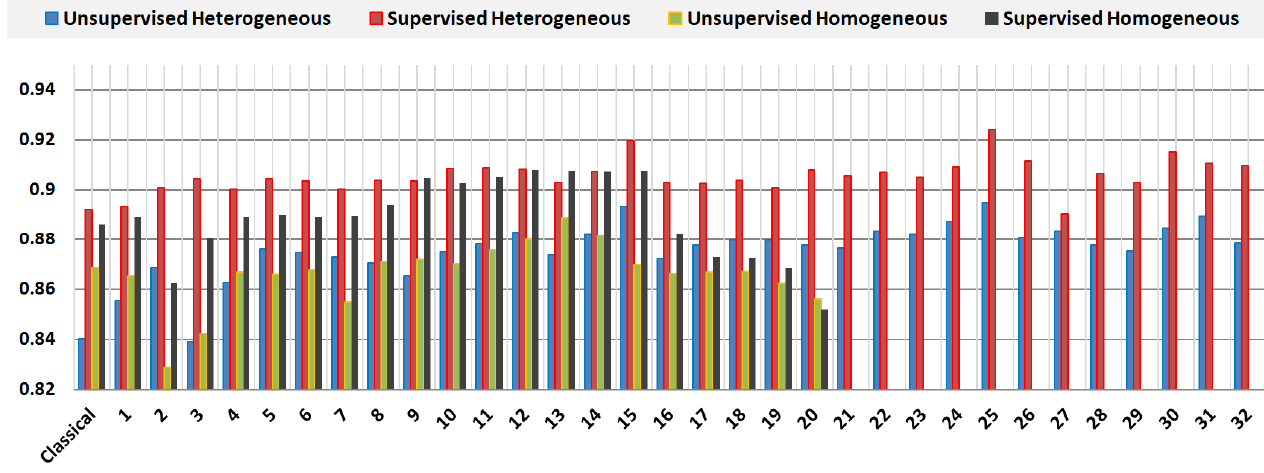
Figure 5. Supervised and unsupervised performance measure comparing MCET using the classical mean, homogeneous mean estimation approach, and the heterogeneous mean estimation approach.